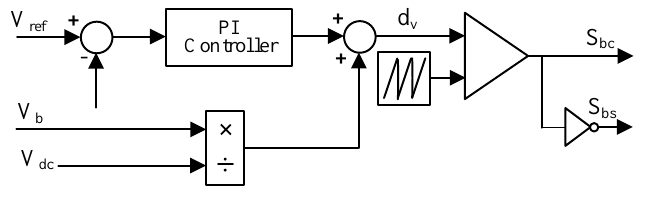
Figure 10. Control scheme for the DC/DC converter in buck mode.